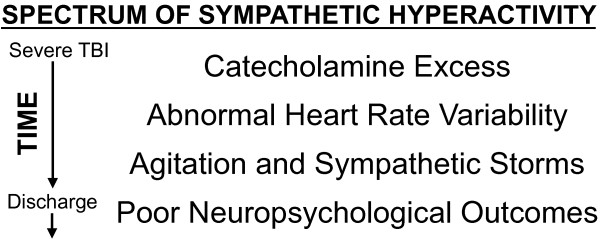
Conceptual model of sympathetichyperactivity after severe TBI.